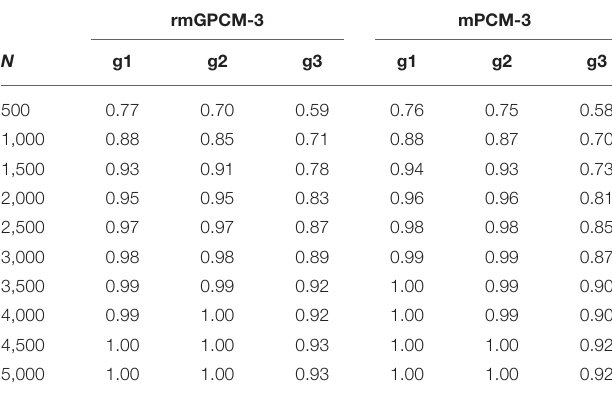
TABLE 4 | Averaged Spearman’s rank correlations between the generating and estimated 1β i 0 sg -parameters for the rmGPCM-3 and the mPCM-3 under the condition of a true three-class mixture and a 5-item scale with 11